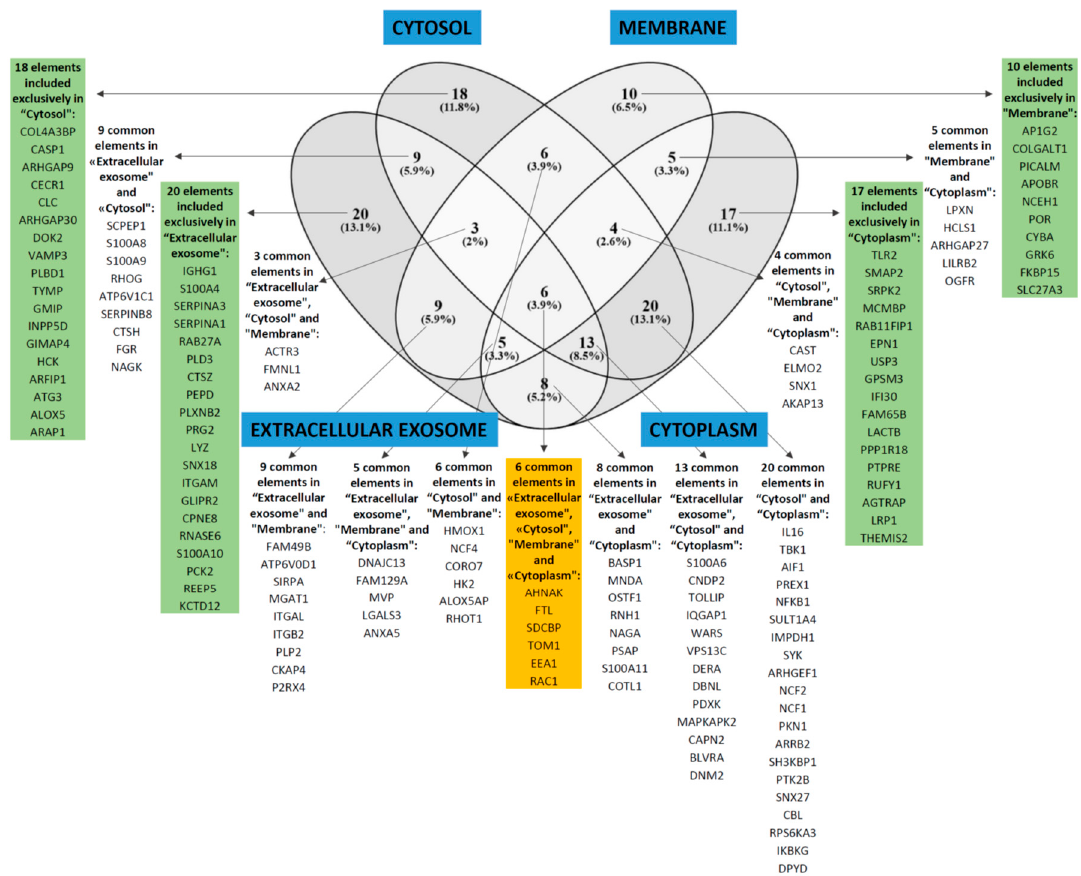
Figure 4. GO-terms including significantly increased proteins for AML cells with generally high constitutive release of extracellular soluble mediators. The over-representation analysis based on cellular compartment identified four GO terms with FDR < 0.05 and including at least 40 proteins, i.e., GO:0070062—extracellular exosome, GO:0005829—cytosol, GO:0016020—membrane, and GO:0005737—cytoplasm. These four GO-terms were partly overlapping (only six proteins included in all four); together they included 153 of the 186 proteins that were increased in AML cells with generally high constitutive release compared with AML cells with low/intermediate constitutive release.